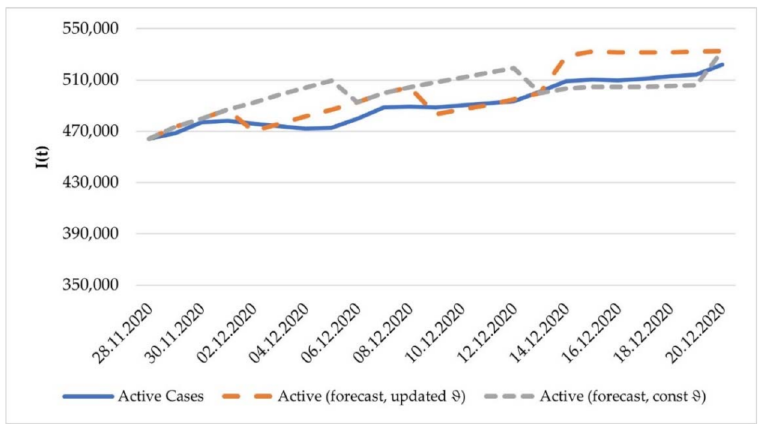
Figure 8. Dynamics of I ( t ) , the actual and modeled trajectories in the interval from 1 December to 22 December 2020, in a stationary case and at updated values of ϑ ( t ) .